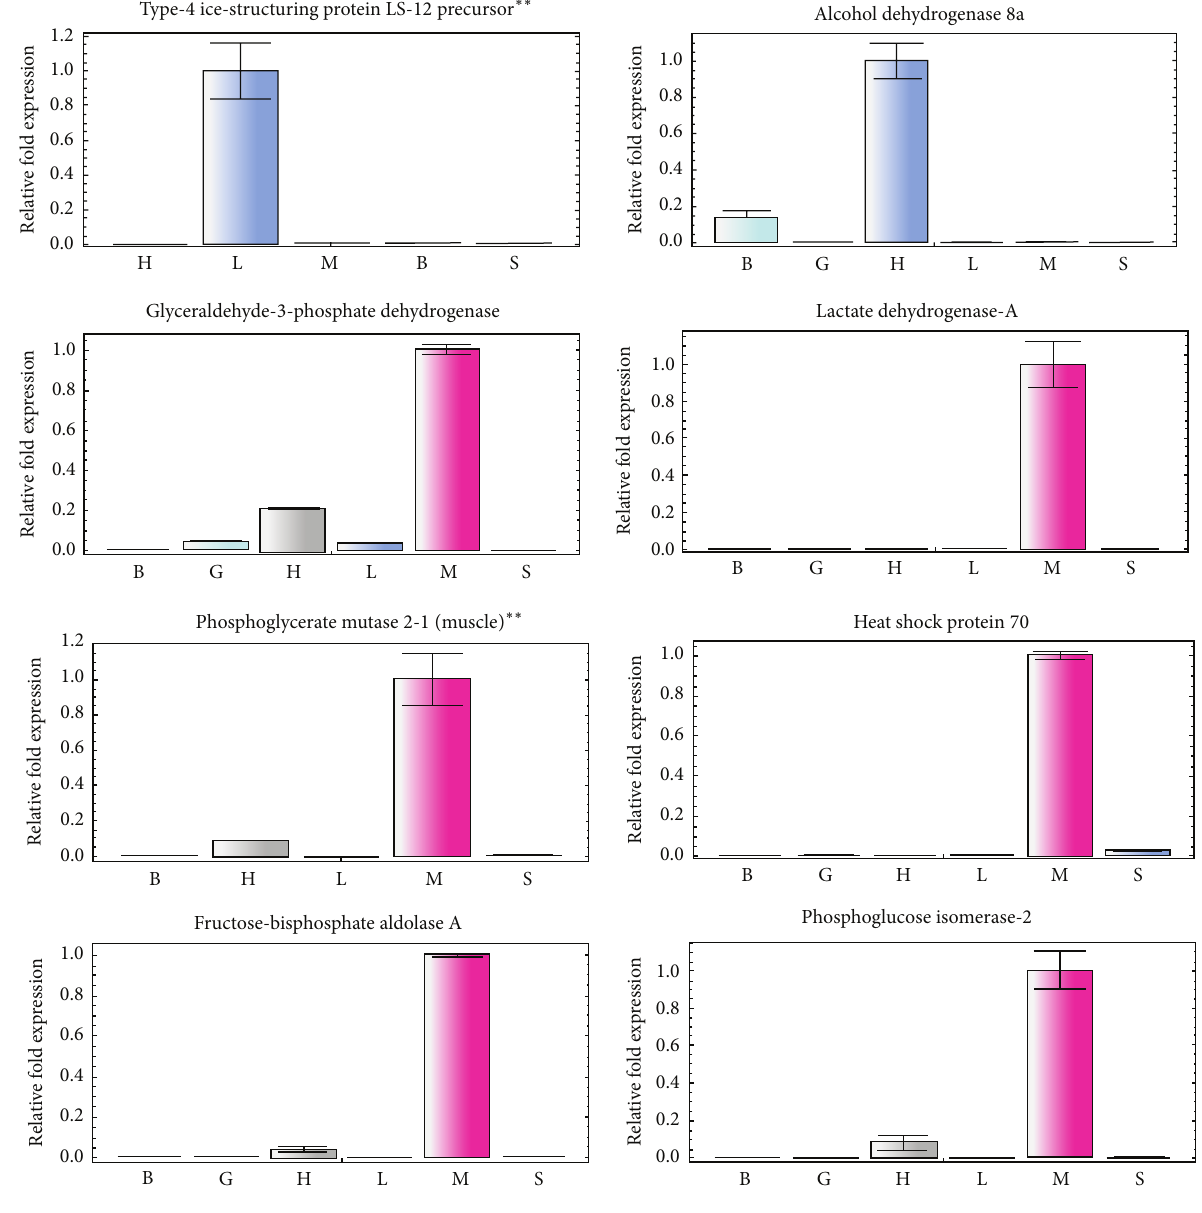
Figure 2: Gene expression normalized to a relative value of 1.0 of all genes selected for this study in different tissues from Aphanopus carbo . S = spleen, B = brain, H = heart, G = gonad, L = liver, M = muscle, ∗ = expression in the brain was below detection and ∗∗ = expression in the gonads was below